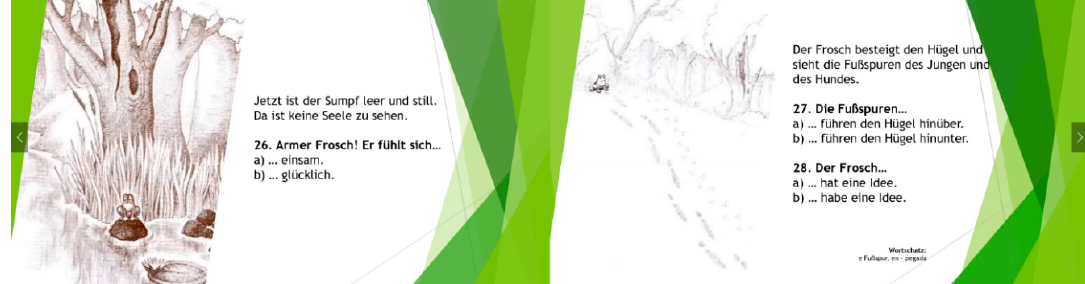
Figure A23. Pretest: Binary-choice recognition task.